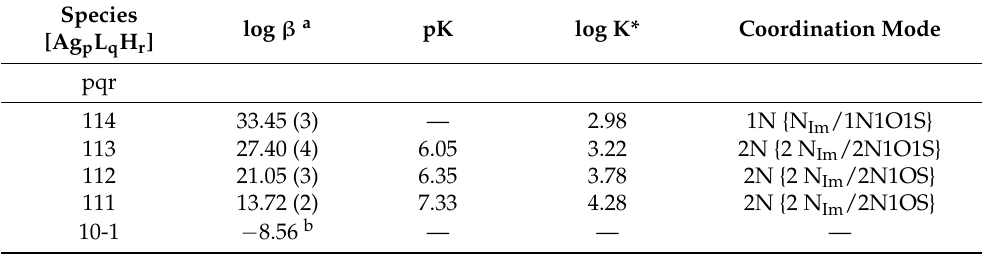
Table 4. Log β values obtained for the Ag + -Ctr1 (1-14) system at I = 0.1 mol dm − 3 (KNO 3 ) and T = 298 K.